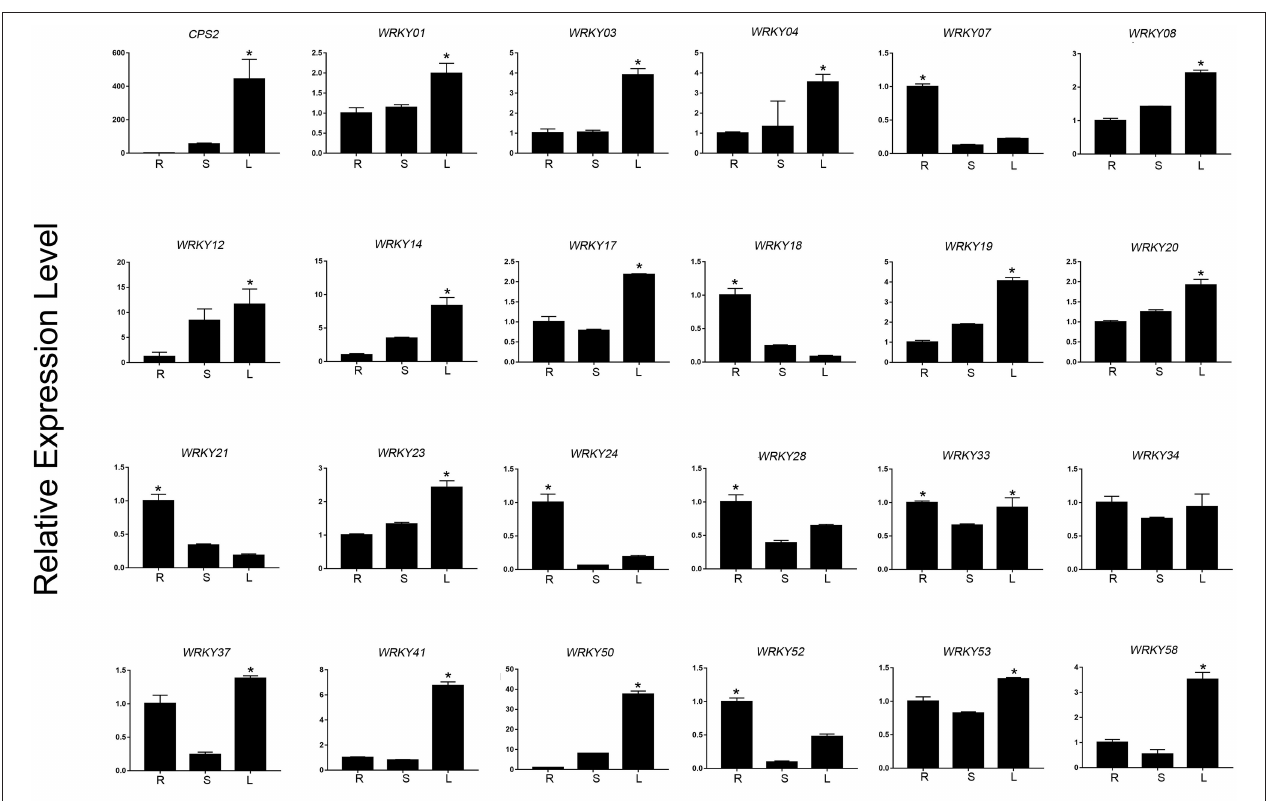
FIGURE 8 | qRT-PCR analysis of ApWRKYs with putative roles in andrographolide biosynthesis in different organs (root, stem, leaf) in A. paniculata . The actin gene was tested as an internal reference. CPS2 was used as the positive control. The asterisks (*) represent significant differences ( P <